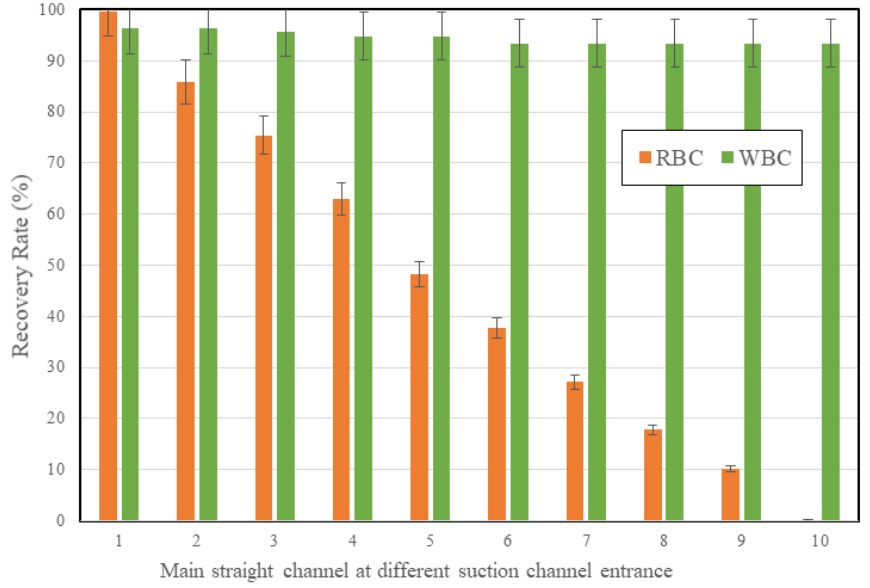
Figure 8. The recovery rate of the RBCs and WBCs in the sample flow after the curve/suction channels — from the first to the tenth curve channels. channels—from the first to the tenth curve